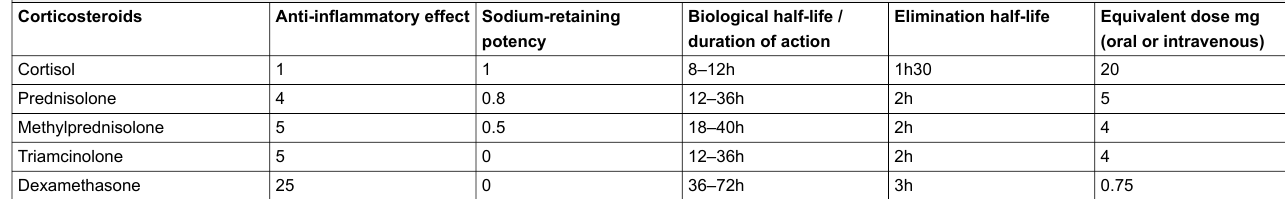
Table 2: Characteristics of corticosteroids (adapted from Schimmer BP, Funder JW. ACTH, Adrenal steroids, and pharmacology of the adrenal cortex. In: Brunton LL, editor. Goodman and Gilman’s The pharmacological basis of therapeutics. 12th ed. New-York: McGraw-Hill; 2011. p. 1209–35 [67]).